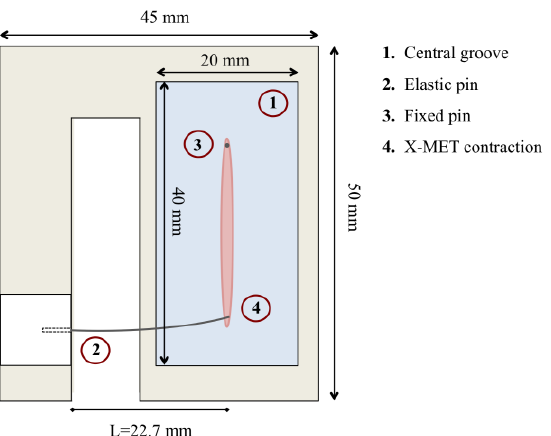
Figure 1. Schematic of the sensor (top view) for the measurement of X-MET